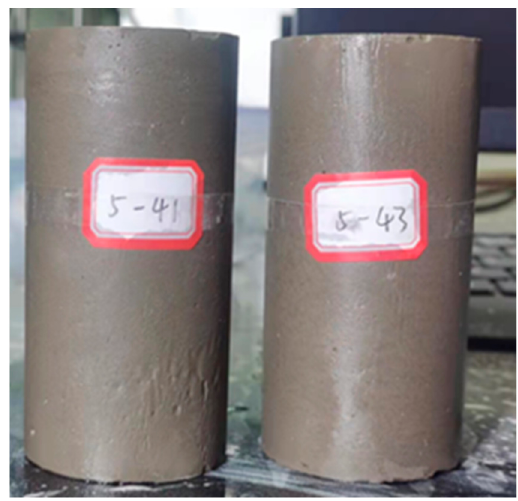
Figure 1. Photograph of cemented soil specimen.